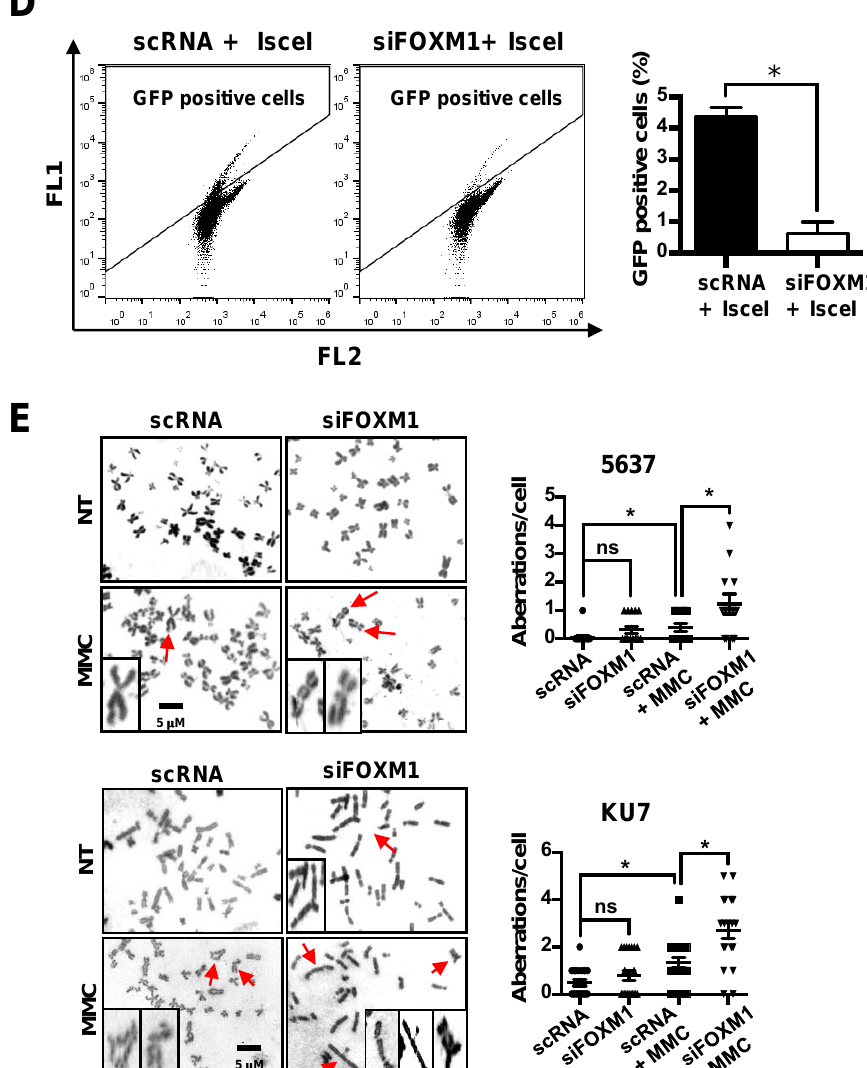
Figure 5. Measurement of DNA damage and repair activity in FOXM1-inhibited bladder cancer